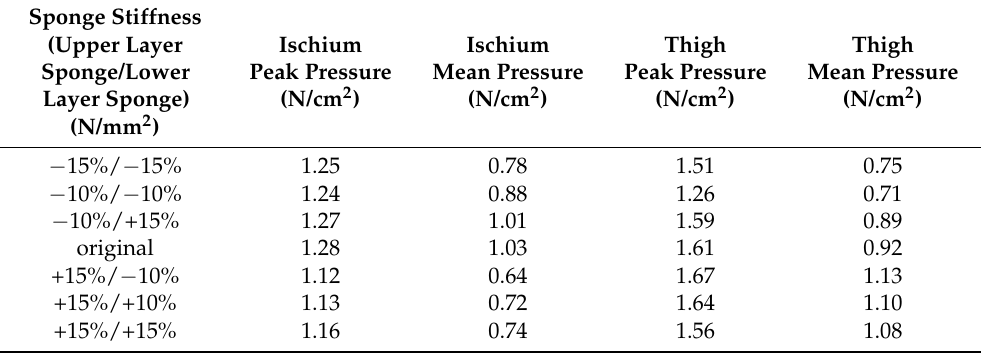
Figure 14. Seat cushion simulation pressure map: ( a ) Sponge hardness − 15%/ − 15%; ( b ) Sponge hard- ness − 10%/ − 10%; ( c ) Sponge hardness − 10%/+15%; ( d ) Sponge hardness +15%/ − 10%; ( e ) Sponge hardness +15%/+10%; ( f ) Sponge hardness +15%/+15%. Table 4. Body pressure comfortable evaluation index of different cushion sponge